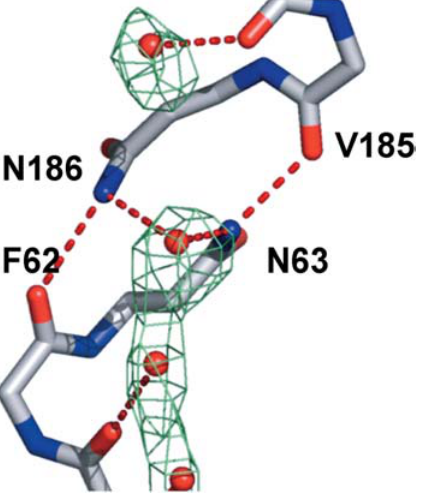
Figure 4. Water at the NPA Region N63 and N186 donate hydrogen bonds to the central water by projecting their NH2 moieties into the pore. This conformation is aided by a hydrogen bond from the adjacent carbonyls of V185 and F62, respectively. Experimental electron density (2F obs – F calc ) is contoured at 0.7 r . DOI: 10.1371/journal/pbio.0000072.g004 PLoS Biology |